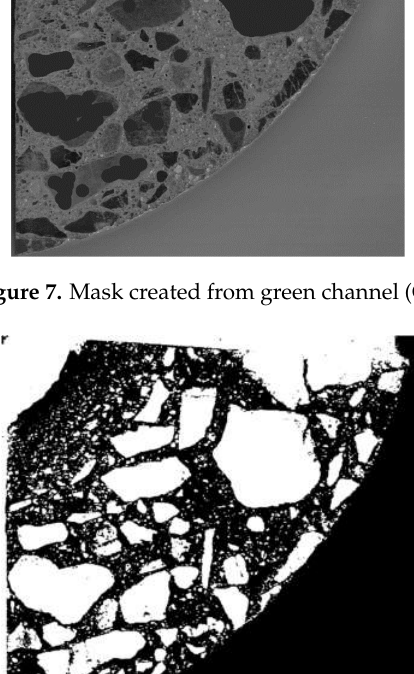
Figure 10. Image of sample after segmentation procedure Step 4. The product of the images from Step 3 and Step 4 (Step 5) is shown in Figure 11. The removal of pores (i.e., black areas completely surrounded by the white area) (Step 6) and the use of a mask confining the area to the surface of the scanned sample are shown in Figure 12. Figure 11. Step 5—product of images from Steps 3 and 4.